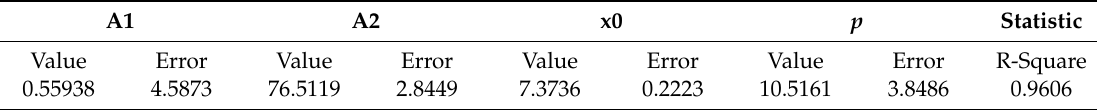
Table 6. Summary of the results of logistic fitting of the sakura